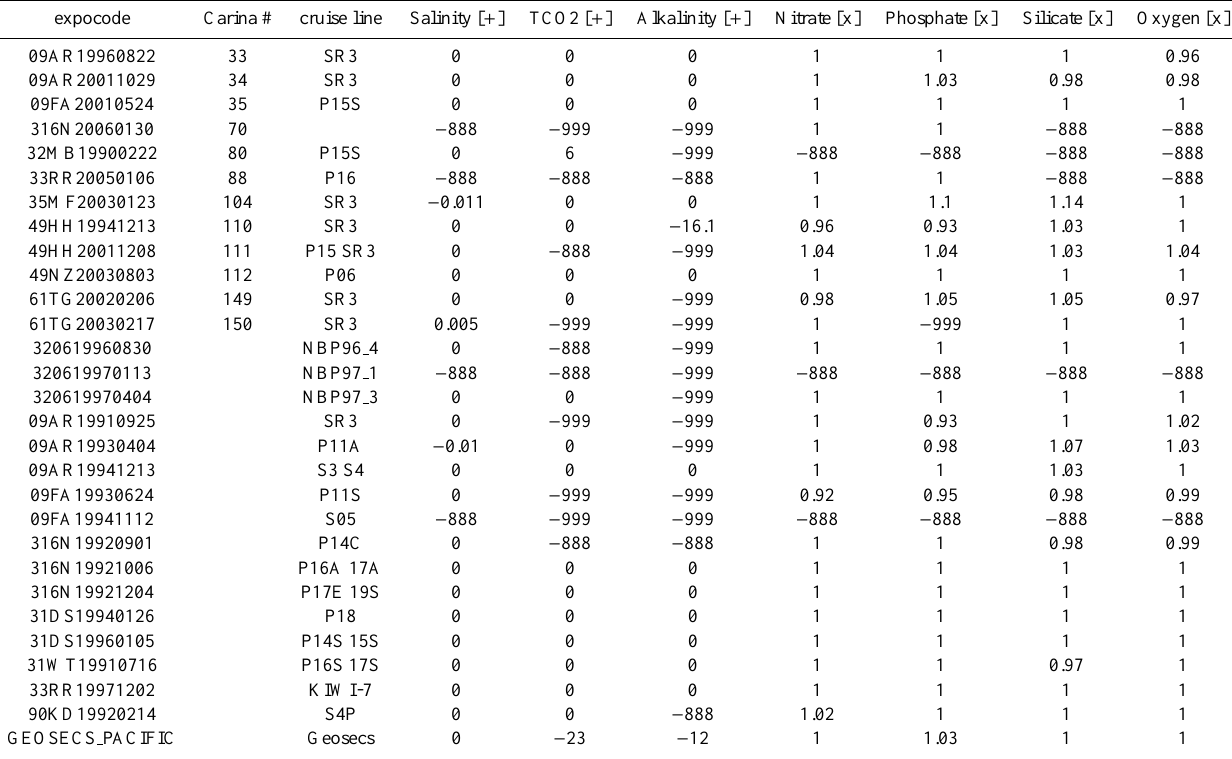
Table 2. Proposed adjustments for cruises included in Pacific sector of the Southern Ocean analysis. A “ − 999” indicates that the parameter was not reported and a “ − 888” means that the parameter was measured but not